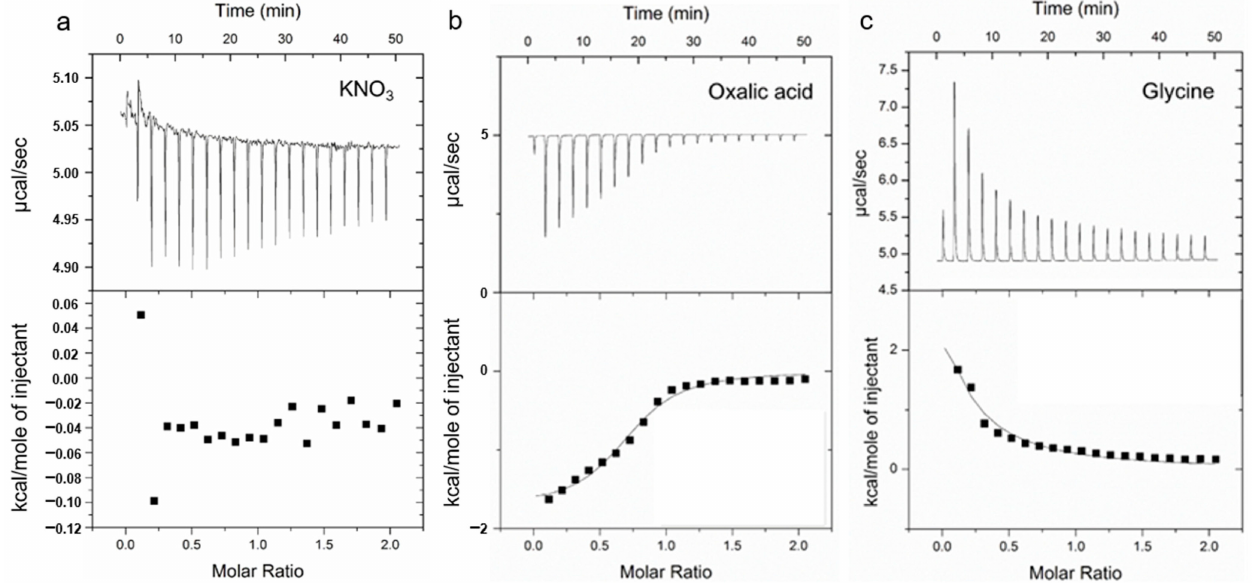
Figure 5. Isothermal titration data for the addition of Cu(II) to oxalic acid (carboxyl) ( b ), glycine (amino) ( c ) in 1 mol/L KNO 3 background electrolyte (pH 5) at 25 ◦ C ( a ). The upper and lower panels of each graph represent calorimetric titrations (heat flow) and integrated heat values, respectively. The solid line represents the best independent model fitting